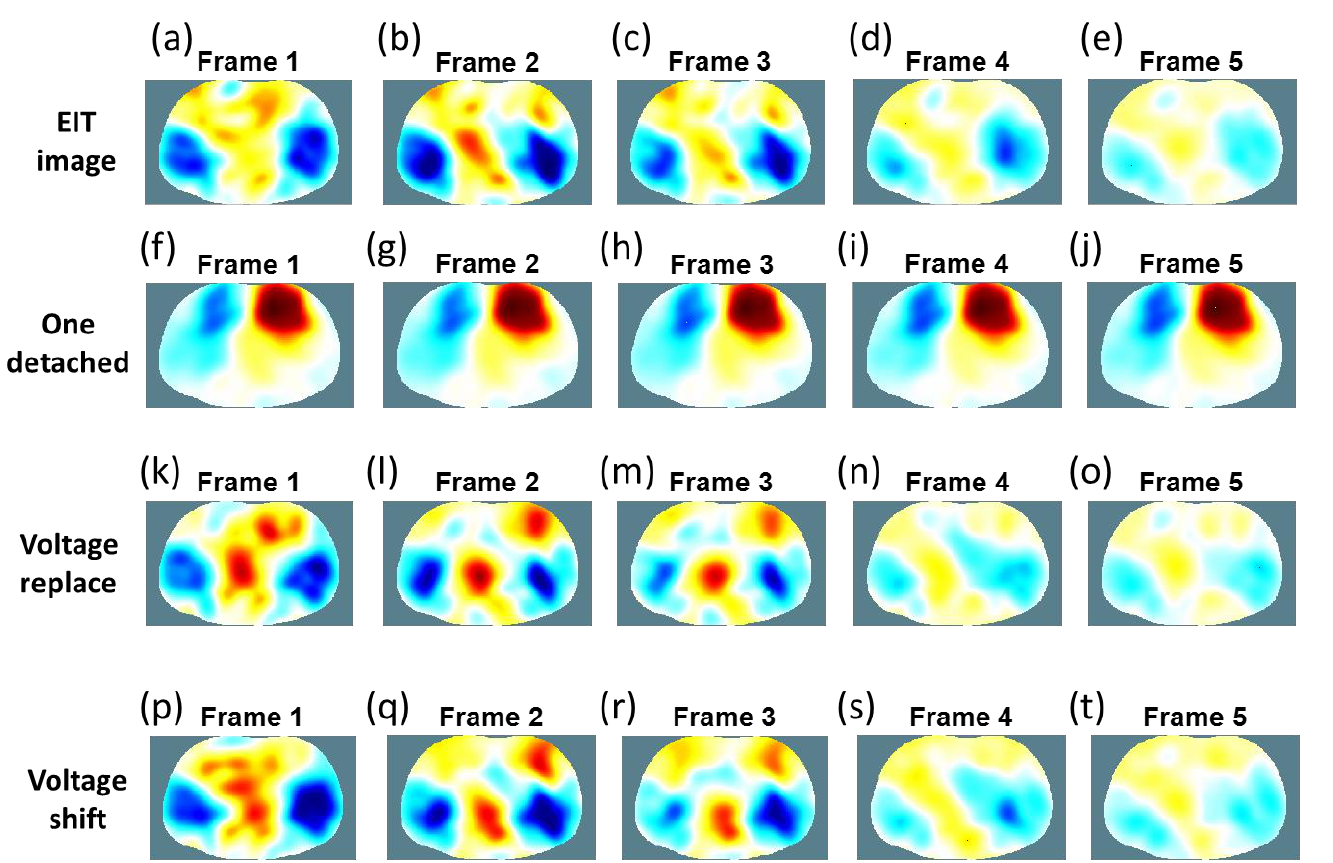
Figure 12. The EIT images of the chest over one breathing cycle. ( a ) Frame 1 of the EIT image. ( b ) Frame 2 of the EIT image. ( c ) Frame 3 of the EIT image. ( d ) Frame 4 of the EIT image. ( e ) Frame 5 of the EIT image. ( f ) Frame 1 of the faulty image. ( g ) Frame 2 of the faulty image. ( h ) Frame 3 of the faulty image. ( i ) Frame 4 of the faulty image. ( j ) Frame 5 of the faulty image. ( k ) Frame 1 using the voltage-replace method. ( l ) Frame 2 using the voltage-replace method. ( m ) Frame 3 using the voltage-replace method. ( n ) Frame 4 using the voltage-replace method. ( o ) Frame 5 using the voltage-replace method. ( p ) Frame 1 using the voltage-shift method. ( q ) Frame 2 using the voltage- shift method. ( r ) Frame 3 using the voltage-shift method. ( s ) Frame 4 using the voltage-shift method. ( t ) Frame 5 using the voltage-shift method.